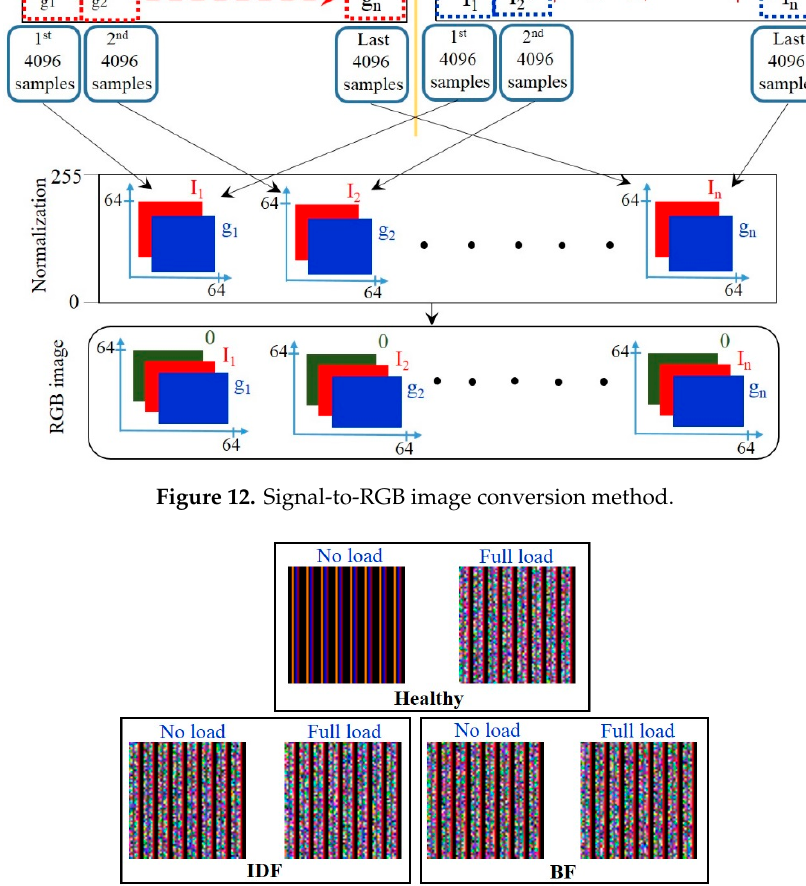
Figure 13. RGB images obtained after performing the signal to image conversion.